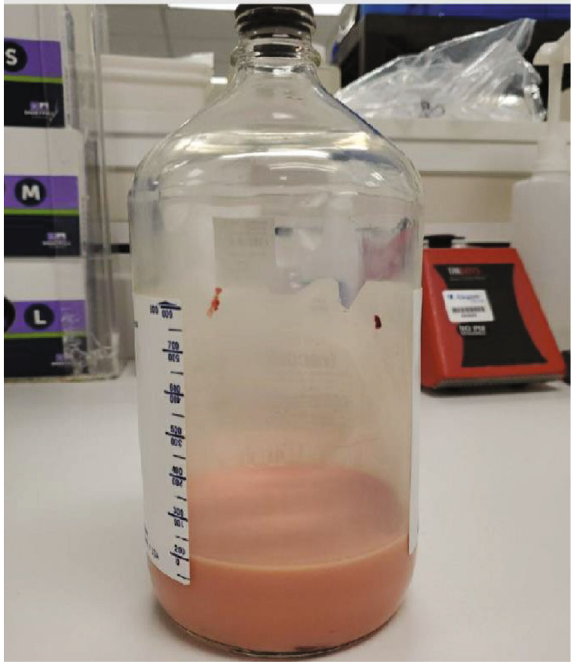
Figure 3: Chylous pericardial fl